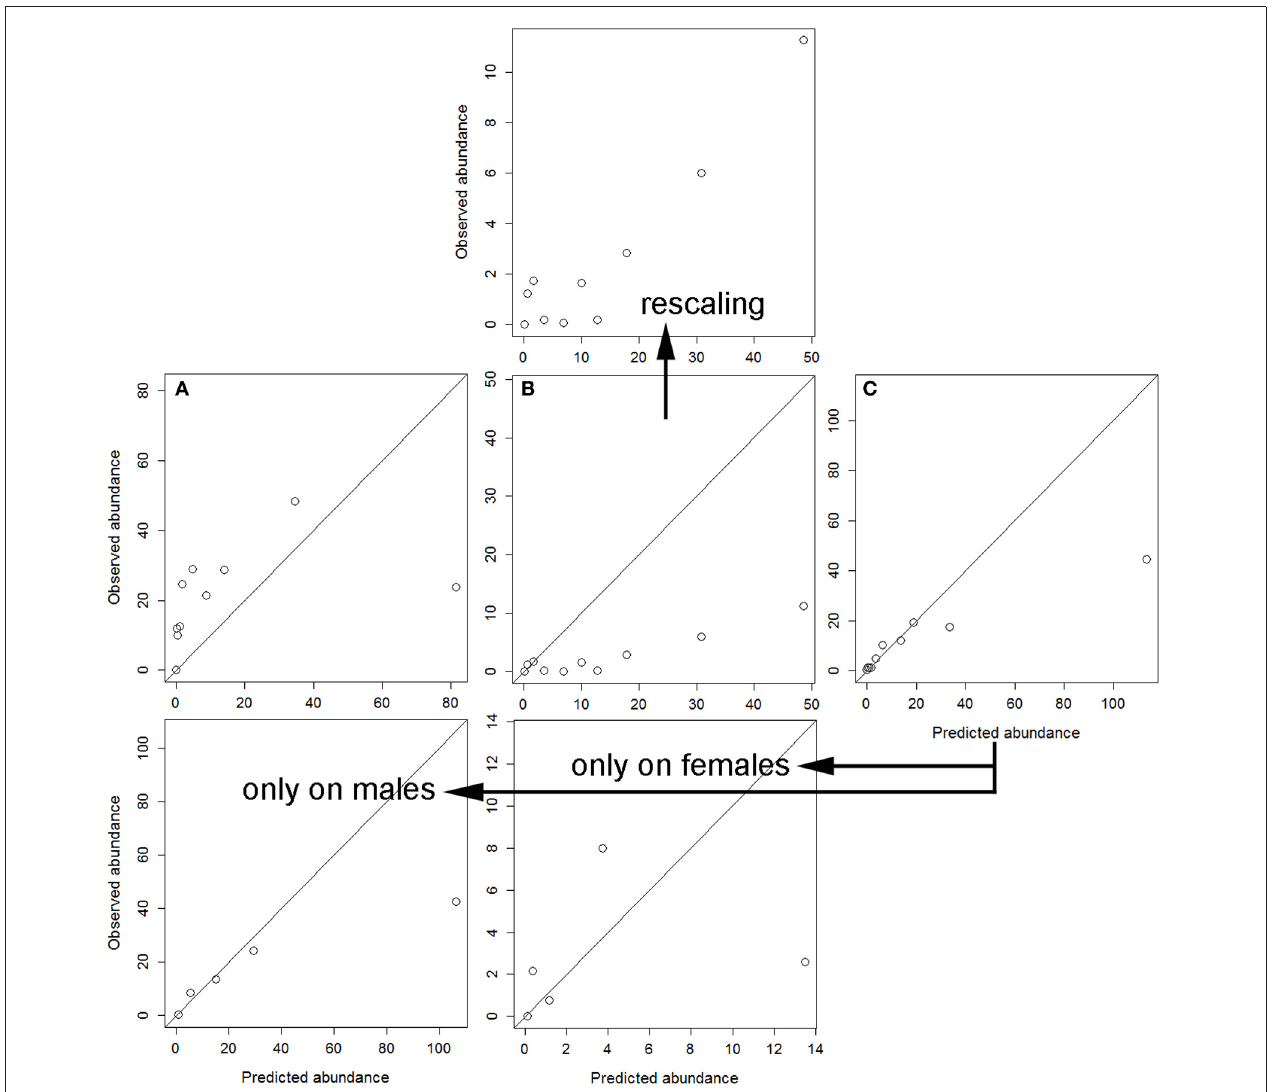
FIGURE 2 | Calibration’s assessment of the three models (see Table 5) under a cross-validation procedure: (A) predictions from the model for hinds on the dataset for males; (B) predictions from the model for males on the dataset for hinds (also rescaling the observed